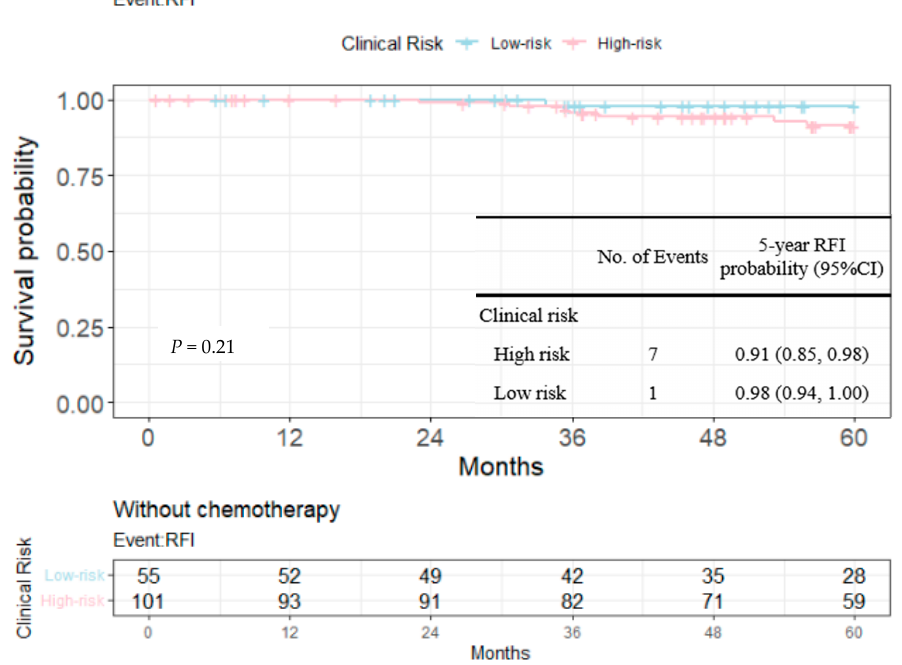
Figure 7. Kaplan–Meier plot for the RFI among patients without chemotherapy within 5 years to compare the partition of clinical risk. Blue: clinically low-risk group; red: clinically high-risk group.